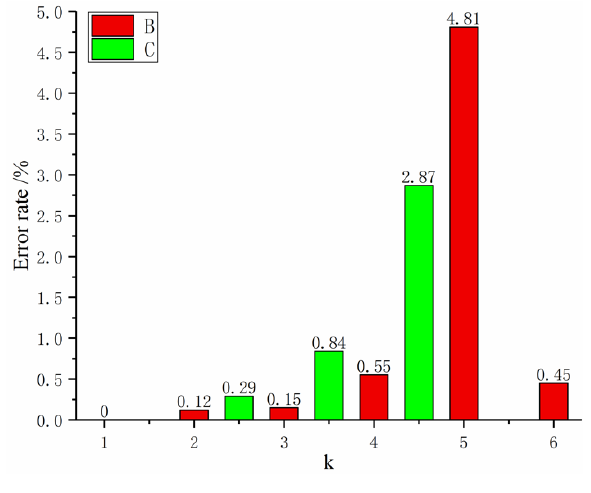
13 of 18 Figure 3. Model 1 relative error rate map. B: relative error of the fit; C: predicted relative error. In Figures 3, 4 and 5, term B represents the relative error of the fit, and C represents the predicted relative error. Figure 3 shows that the maximum error is 41.33%. Further calculation shows that the average fitting error of the MGM(1,4) model is 8.62%, which does not meet the required accuracy requirements. Model improvements are needed to accommodate the current multivariate prediction of nanofiber diameter problems. The selection of the background value coefficient α affects the sequence of system background values, thereby affecting the sequence of predicted values. The automatic optimization and weighting method is adopted to find the best background value coefficient from the internal modeling principle; this will improve the accuracy of the model.